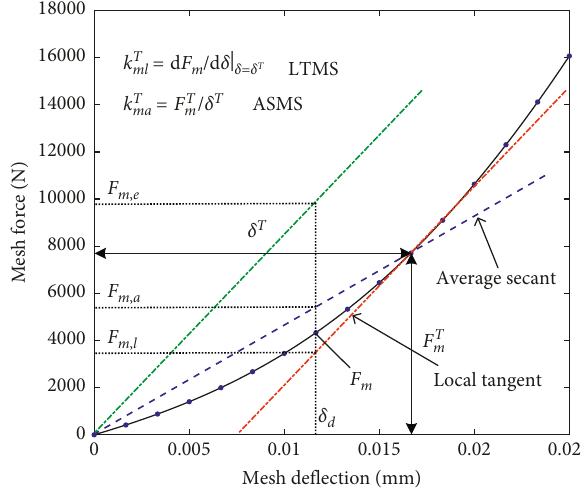
Figure 8: A typical fitted force-deflection curve and illustration of the local tangent mesh stiffness (LTMS) and the average secant mesh stiffness